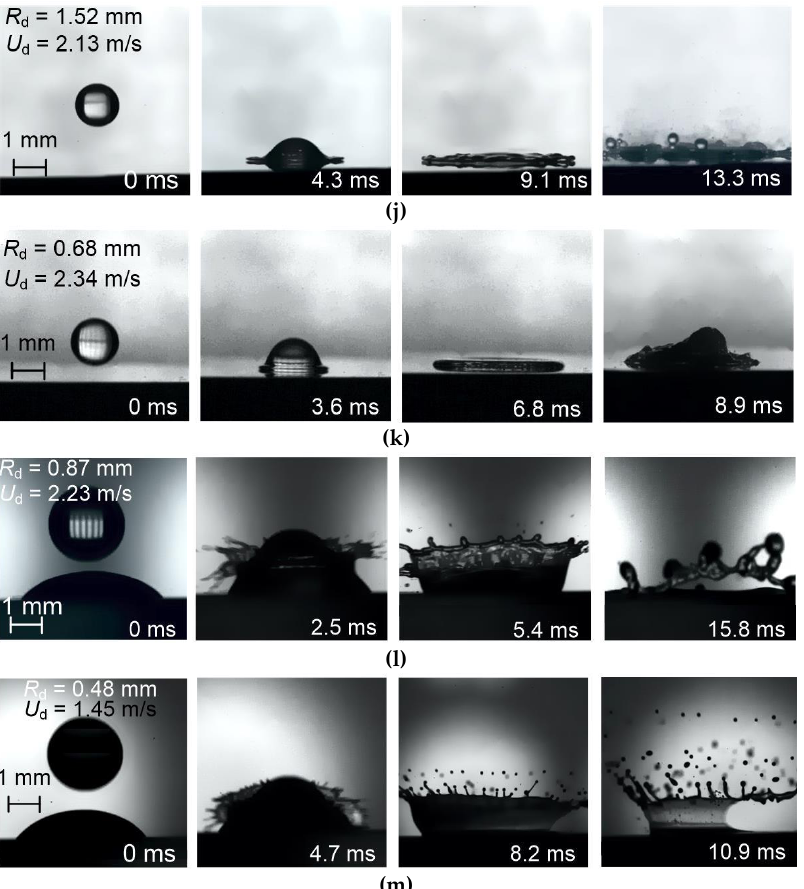
Figure 2. Snapshots of the drop impact on the wall: ( a ) water; ( b ) water; ( c ) water, impingement angle α d ≈ 60°; ( d ) water, impingement angle α d ≈ 30°; ( e ) water, surface with a temperature of T ≈ 50 °С; ( f ) water, surface with a temperature of T ≈100 °С; ( g ) water, surface with a temperature of T ≈180 °С; ( h ) metal surface ( R a =20; 16;10 µm; R z =80; 63; 50; 40 µm); ( i ) water, surface is covered by the transformer oil; ( j ) water, surface is covered by paraffin; ( k ) emulsion (30 vol.% of the transformer oil, 70 vol.% of water); ( l ) emulsion (30 vol.% of the castor oil, 70 vol.% of water); ( m ) slurry (30 wt% of coal, 70 wt% of water).